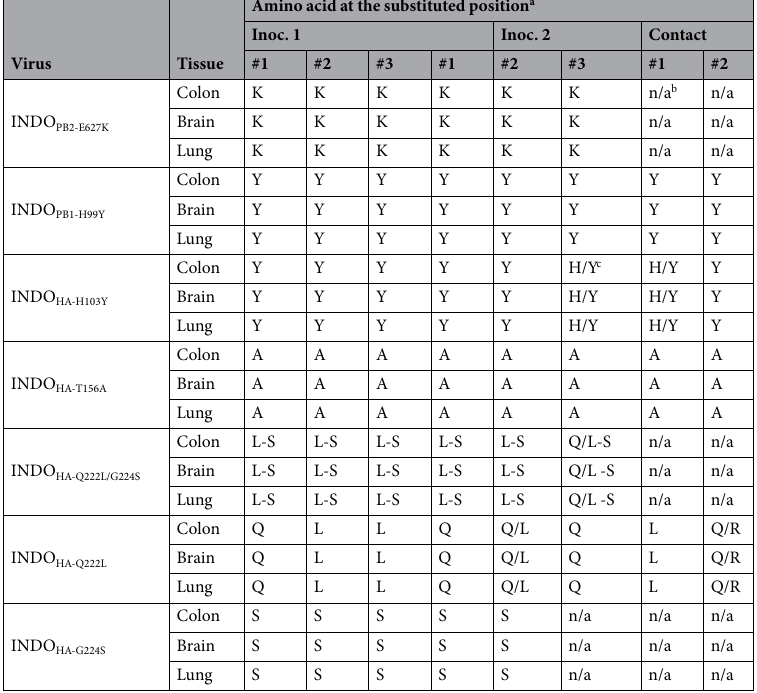
Table 3. Presence of the introduced substitutions in tissues from chickens. a The presence of the introduced substitution was investigated using Sanger sequencing. b n/a: not applicable. c Mixed population detected with Sanger